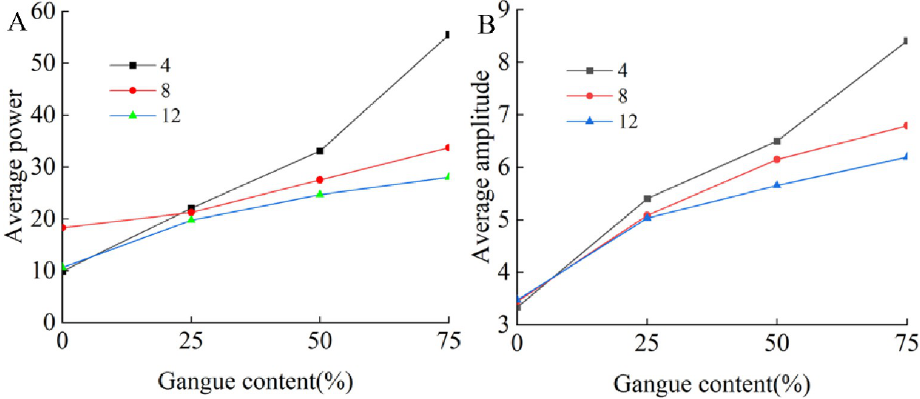
Fig 20. Relationship between gangue content and frequency domain characteristics. (A) Gangue content versus average power under the different rock size. (B) Gangue content versus average amplitude under the different